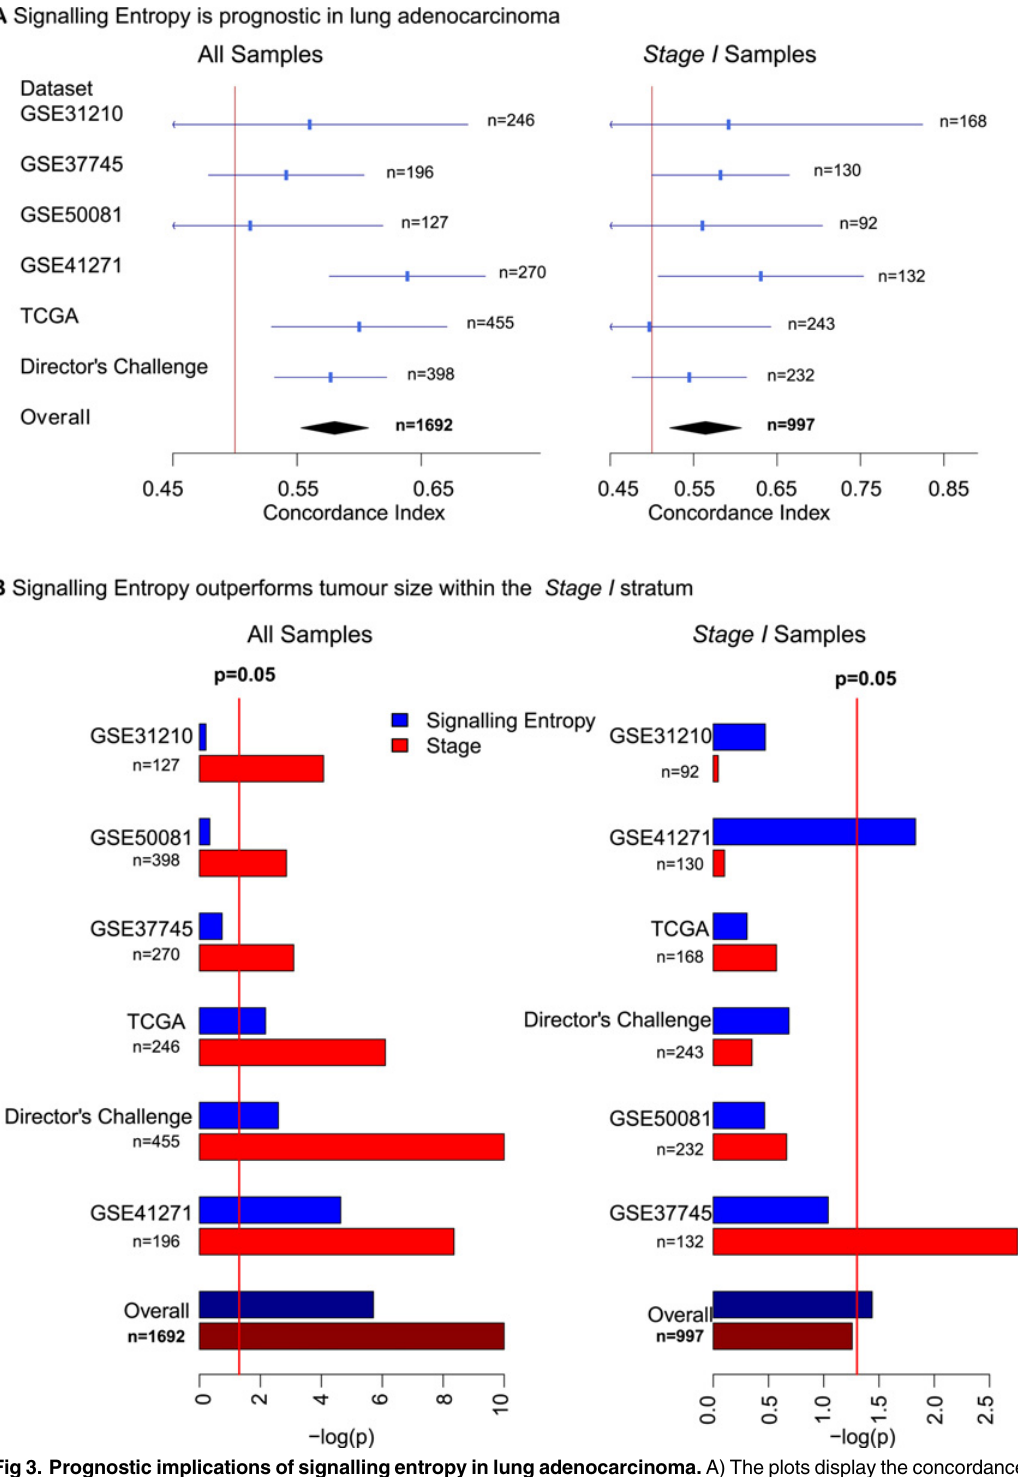
Fig 3. Prognostic implications of signalling entropy in lung adenocarcinoma. A) The plots display the concordance index for signalling entropy in each data set alongside its 95% confidence interval. The overall concordance index was derived via meta-analysis using a random effects model. The vertical line denotes concordance index = 0.5, data sets where the confidence interval for the concordance index crosses this line did not reach significance. Meta- analysis of signalling entropy across 7 lung adenocarcinoma data sets reveals that our measure is significantly prognostic across all samples and within the stage I stratum. B) The plots display the negative of the log 10 of the p -value for a survival analysis using Cox-regression on 3-year censored data,